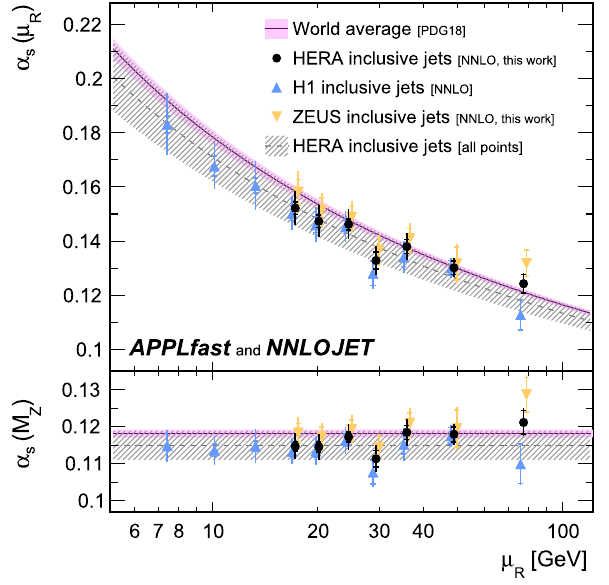
Fig. 6 Results for α s ( M Z ) (lower panel) and corresponding values for α (μ ) (upper panel) from fits to inclusive jet data points arranged s R in groups of similar μ R . The upper panel is obtained by applying the expectation from the QCD renormalisation group equation, as it also enterstheNNLOpredictions.Theinnererrorbarsindicateexperimental uncertainties, and the full error bars the total uncertainty. The upper triangles show results from H1 data, which were previously fit in Ref. [10] and are here partially updated with NNLO predictions with higher statistical accuracy. The lower triangles indicate the new results from ZEUS data. The full circles show the combined results from H1 and ZEUS data taken together and are labeled HERA inclusive jets. The shaded band indicates the world average value with its uncertainty, and the dashed line and hatched band indicate the result obtained from the fit to all inclusive jet data and its